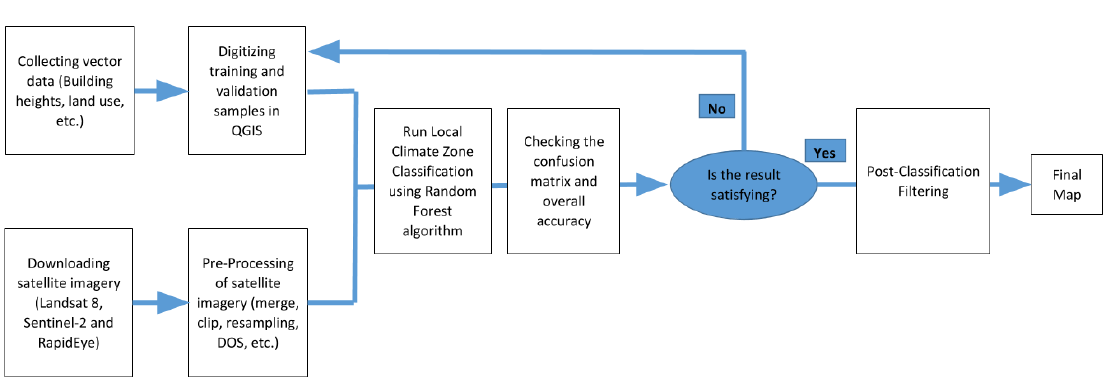
Figure 3. Flowchart adopted for Local Climate Zone (LCZ)